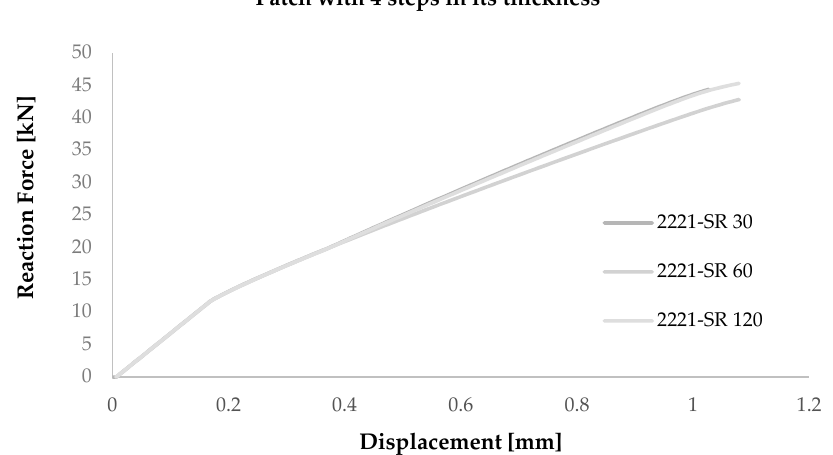
Figure 10. Displacement-Reaction Force curve for repaired laminated with patch with 4 steps through its thickness and 30, 60 and 120 scarf ratio.